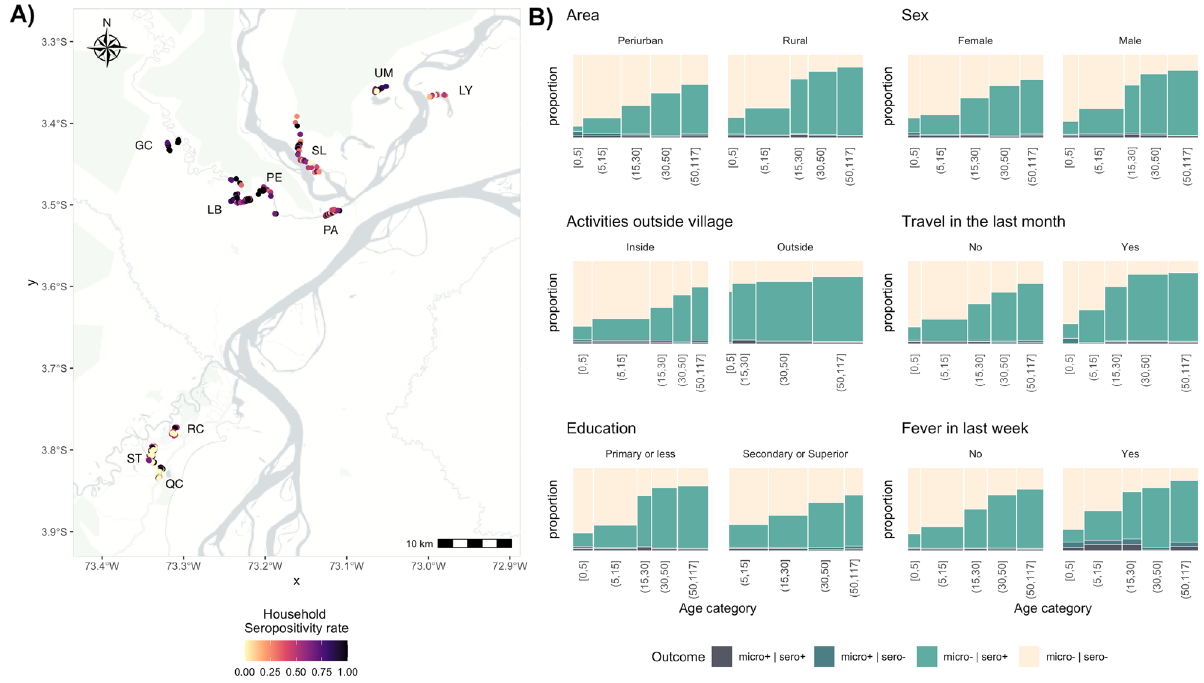
Figure 1. Study area and socio-demographic distribution of seropositivity in the Loreto department in the Peruvian Amazon. ( A ) Seropositivity rate at household level in the villages of Iquitos district (bottom left): Rumococha (RC), Santo Tomas (ST), Quistococha (QC), and Mazán district (top right): Gamitanacocha (GC), Libertad (LB), Primero de Enero (PE), Puerto Alegre (PA), Salvador (SL), Lago Yuracyacu (LY), and Urco Miraño (UM). ( B ) Distribution of serology (sero) and microscopy (micro) rates across age categories and sociodemographic variables. Maps were produced using R v.4.1 (R Development Core Team, R Foundation for Statistical Computing, Australia) based on public geographic data extracted from OpenStreetMap contributors (www. opens treet map. org) under Open Data Commons Open Database License (ODbL) 1.0 (http:// opens treet map. org/ copyr